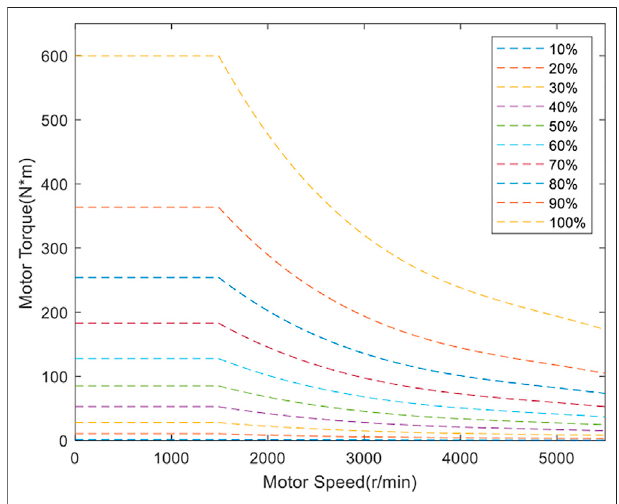
FIGURE 8 | Economic torque